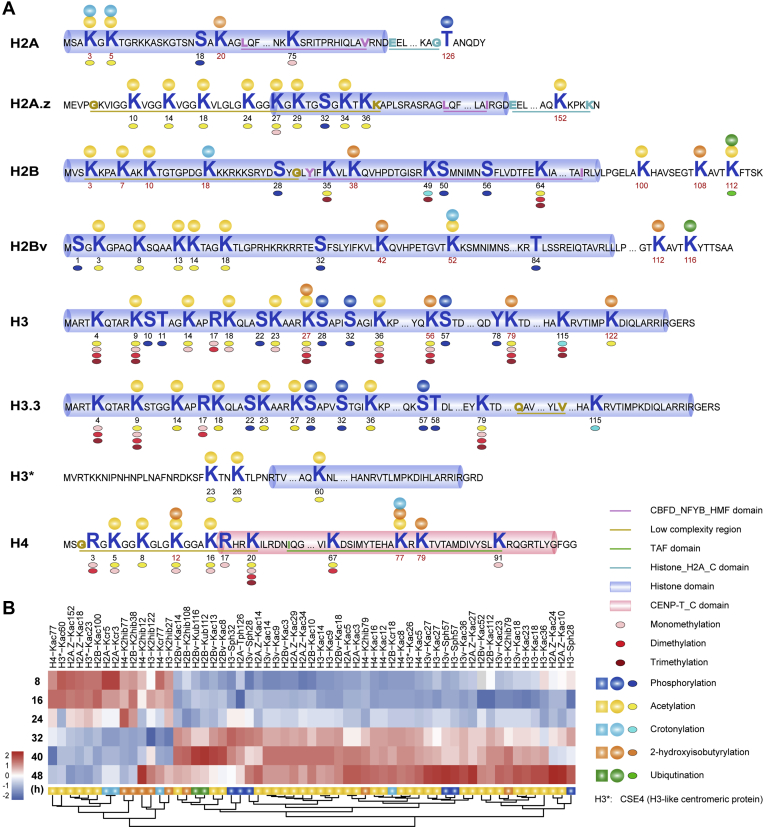
PTMs of histones (H2A, H2B, H3, and H4) and histone variants (H2A.z, H2B variant, H3 variant, and H3-like centromeric protein CSE4). A, distribution diagram of modification sites of histones and histone variants. The conserved domains, including the histone domain, Histone_H2A_C domain, CBFD_NFYB_HMF domain, CENP-T_C domain, low complexity region, and TAF domain, are marked with colored lines. The PTMs identified in this study are presented on the corresponding amino acids, and novel PTMs identified are indicated with circular spheroids with gradient colors. PTMs identified earlier are represented underneath the corresponding amino acids in small oblate spheroids with even colors. Methylation (including monomethylation, dimethylation, and trimethylation) identified earlier is also displayed in addition to the modifications involved in this research. B, dynamic cluster heatmap of quantifiable modification sites on histones and histone variants. Log2 geometric means of normalized expression values (from the signal intensity of MS/MS) of the three repetitions were used to indicate the abundance of the modification site at a specific time during the IDC. The redder the color, the higher the abundance. The bluer the color, the lower the abundance. The middle color is white. The modification sites are named “histone name-amino acid-site number-PTM type.” (Notes: In most PTM-omics studies, the number of amino acid positions takes the starting amino acid methionine [M] as Position 1, so “M” was marked as Position 1 in the full text of this article. However, the number of sites of histones takes the next amino acid “M” as Position 1 in the existing histone modification research on P. falciparum. To facilitate the comparison and discussion with the existing literature, we subtracted one from the number of all histone sites, which was consistent with the previous studies on histone modifications in P. falciparum.) IDC, intraerythrocytic development cycle; PTMs, posttranslational modifications.